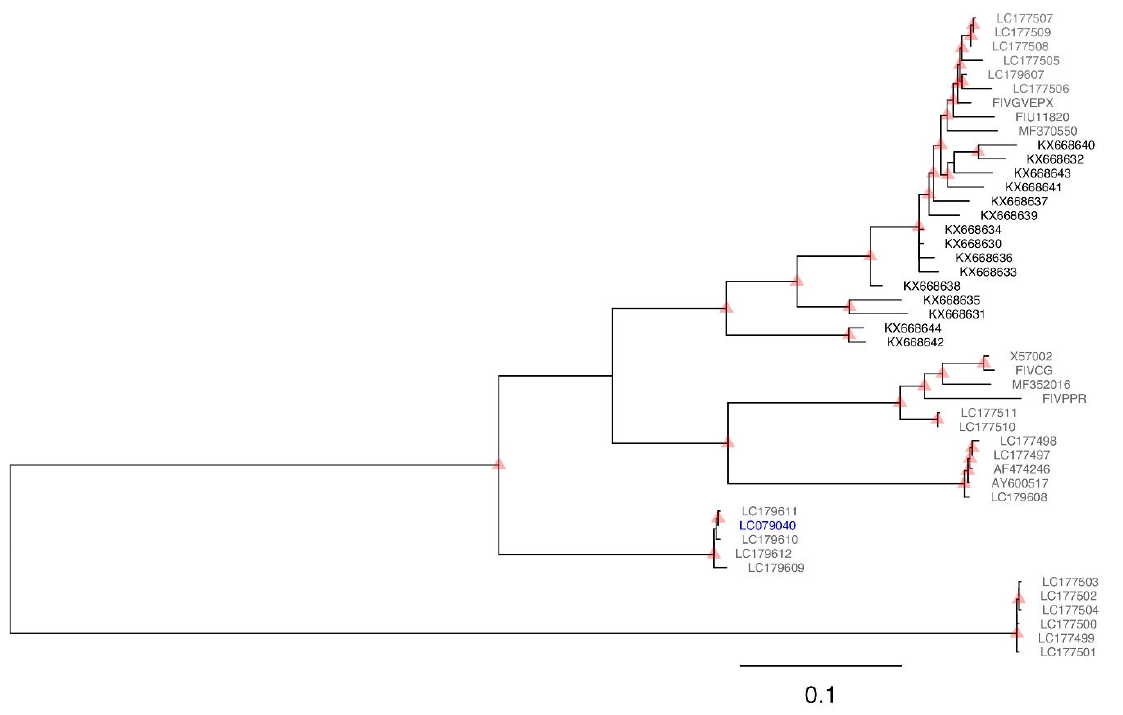
Figure A1. Mid-point rooted maximum-likelihood phylogenetic tree of 46 samples from feline immunodeficiency virus (FIV) vif . Bold tips mark the sequences described in this study. The tip marked in blue was used as reference sequence in the hypermutation analyses. Red triangles at the nodes mark Approximate Likelihood-Ratio Test (aLRT) support values >70. Branch lengths are drawn to scale with the bar at the bottom indicating nucleotide substitutions per